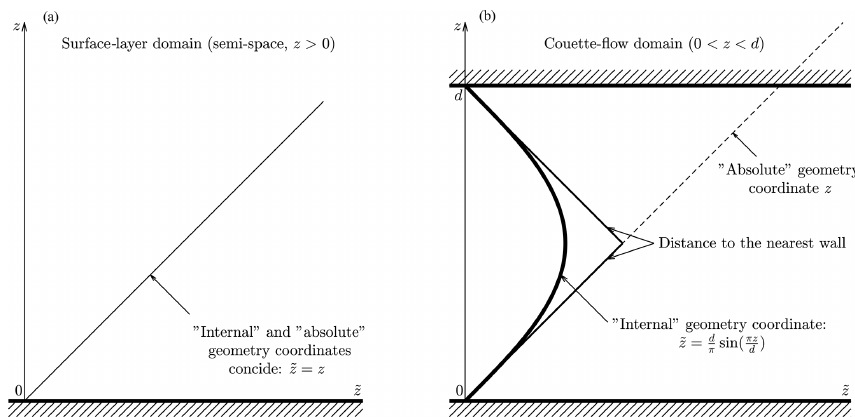
Figure 1. Usual height, z , and vertical coordinate, e z , defined by Eq. (12) characterizing “absolute” and “internal” geometry of the domain, respectively. Panel (a) shows semi-space, z > 0, where e z = z . Panel (b) shows the layer between two horizontal walls, 0 < z < d , where e z coincides with the distance from nearest surface in its close vicinity, but essentially depends on the distances from both surfaces in the central part of the domain.